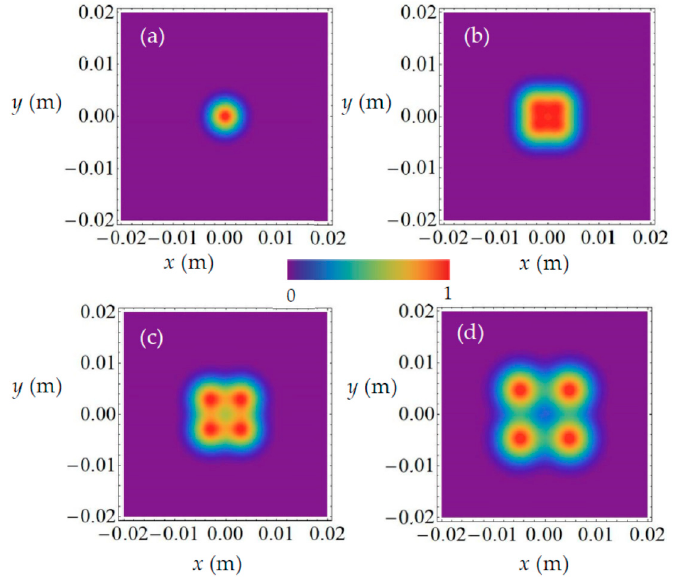
Figure 3. Density plots for the normalized spatiotemporal intensity I ( x , y , t , z ) (Equation (20)) of SCTLGSM pulsed beam in the x – y plane at some propagation distances: ( a ) z = 0, ( b ) z = 30 m, ( c ) z = 40 m, ( d ) z = 60 m and for t = 0, s = 0, m = 1.